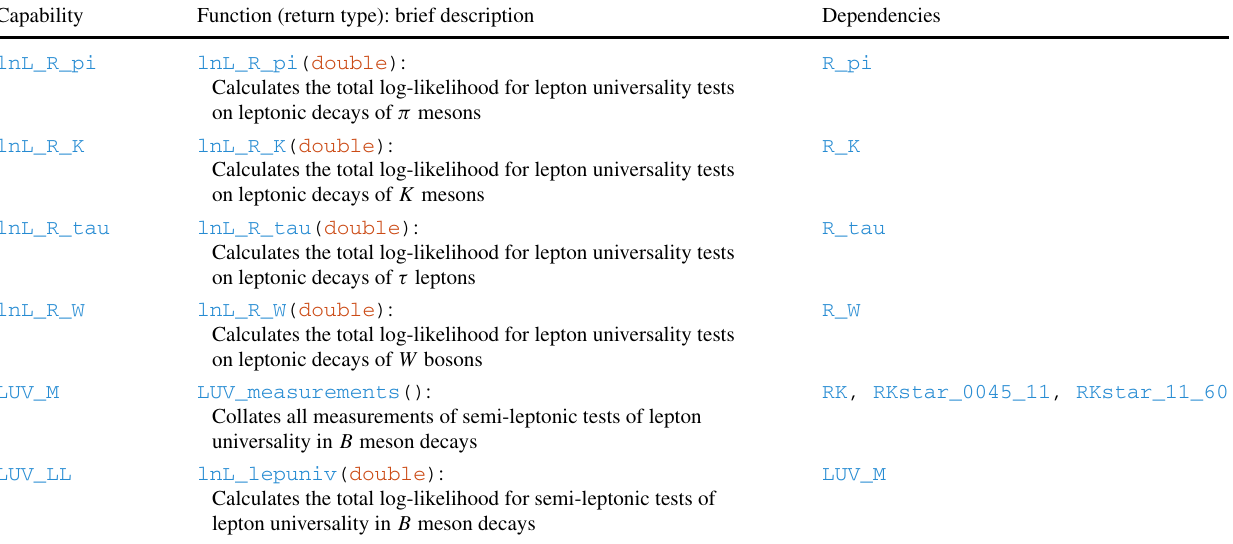
Table 14 Capabilities and module functions for the likelihoods computed for lepton universality tests